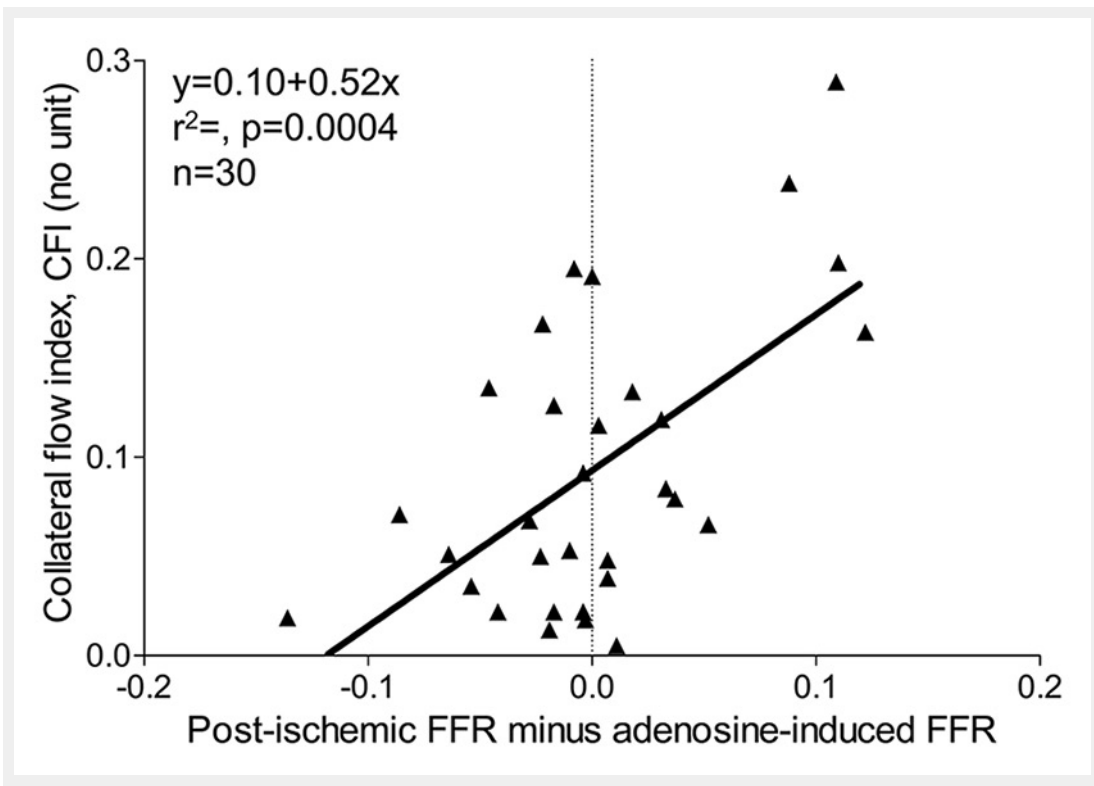
Figure 5 Relation between the fractional flow reserve (FFR) difference (post-ischaemic minus adenosine-induced FFR, x-axis) and collateral flow index as obtained in the same vessel (y-axis).